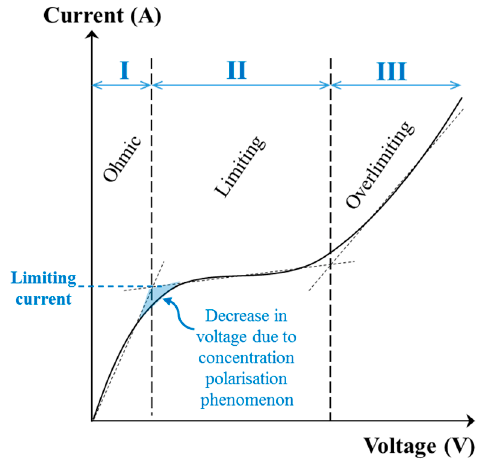
Figure 7. Typical current-voltage curve for an ion-exchange membrane and value of the limiting current (adapted from Bazinet and Castaigne [11]).